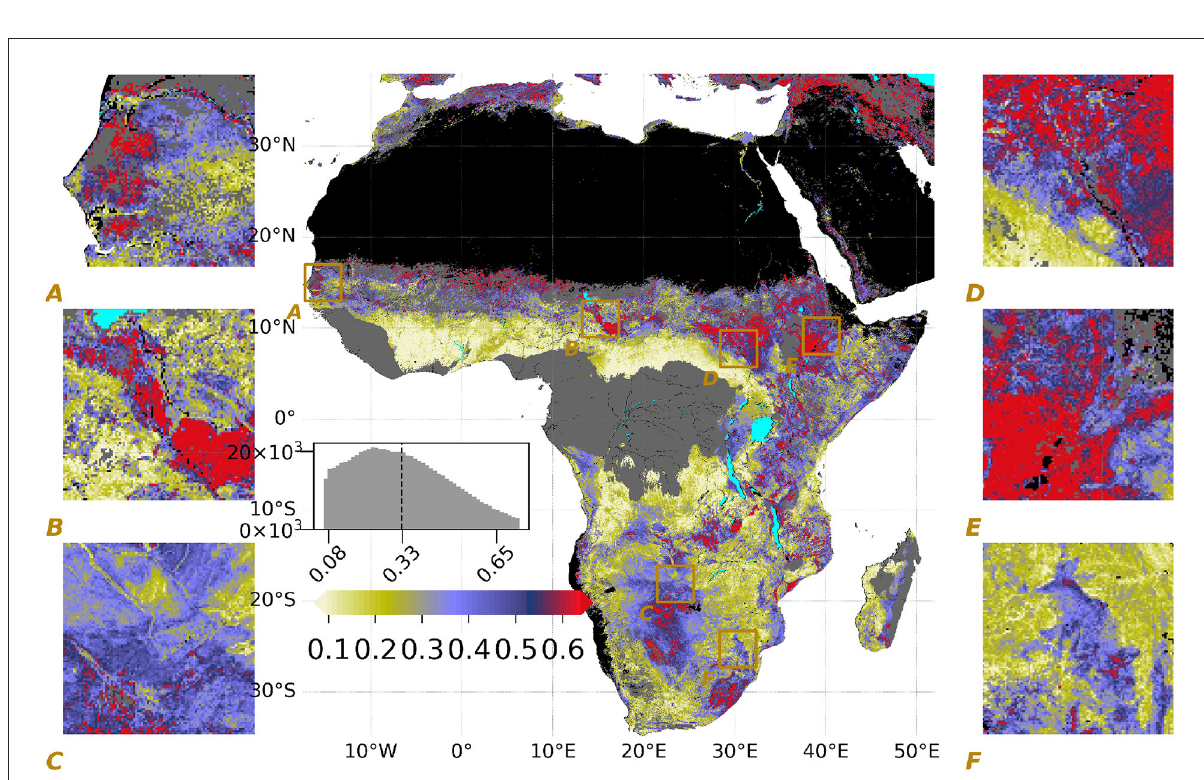
FIGURE2 Spatial variations of the normalized importance of terrain on λ ( 8 terrain − total ) as the output of Equation 2 where larger (blue to red) values indicate higher importance of terrain parameters. Refer to Figure 1 for plotting